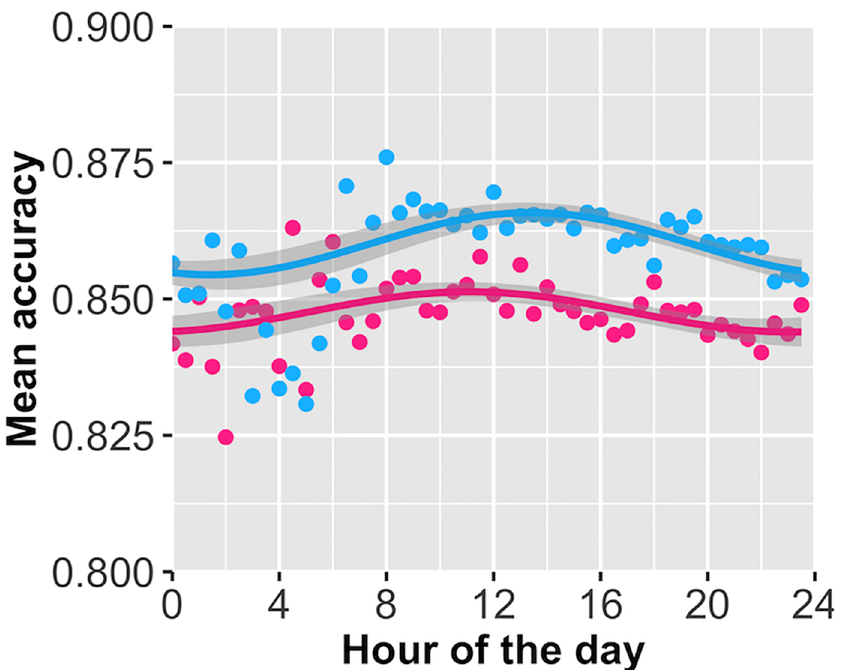
Fig 4. Daily session accuracyover 24 hours with 1st harmonic regression line. Notes: Both lines are 1 st harmonic regressionlines fit to data. Red = sample 1 data. Blue = sample 2 adjustingfor users’ time-zone. Shadedregionsrepresent the 95% CI of the fixed effect. Dots represent the averagescore across sessions for each 30-minutewindow.